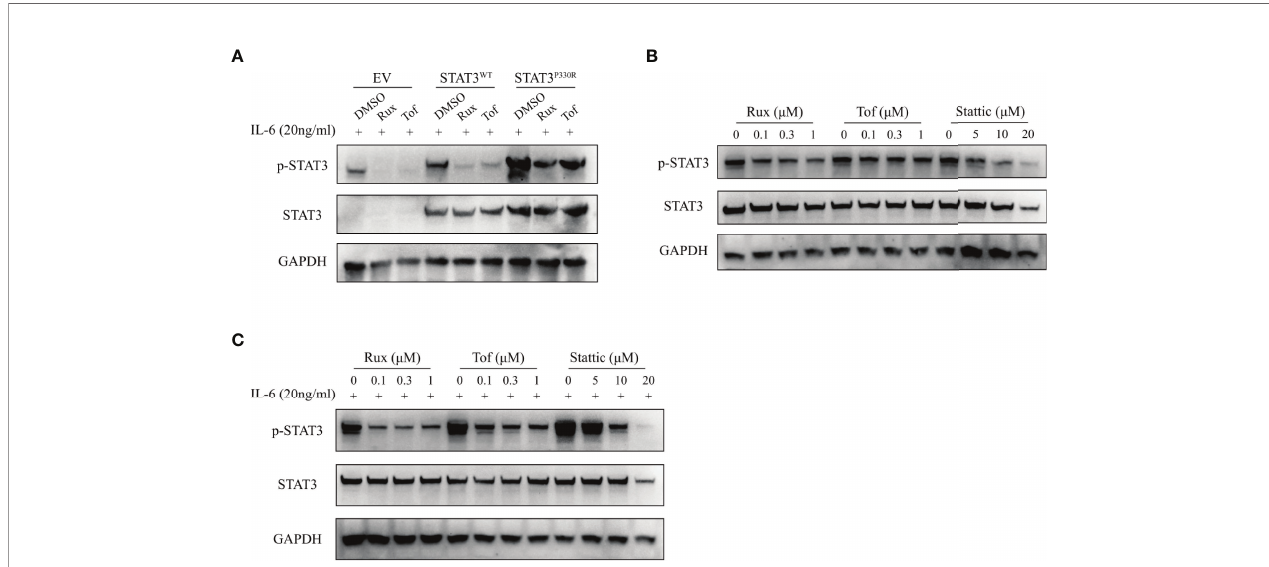
FIGURE 5 | The suppression of STAT3 phosphorylation by JAK and STAT3 inhibitors. (A) The transfected HEK293 cells were treated with dimethylsulphoxide (DMSO), ruxolitinib (Rux), or tofacitinib (Tof), respectively, and then activated with IL-6 (20ng/ml). The phospho-STAT3 level was examined. (B, C) The transfected HEK293 cells were treated with ruxolitinib, tofacitinib or stattic at the indicated concentration and then activated without (B) or with (C) IL-6 (20ng/ml). The phosphorylation of STAT3 was examined by western blot. The total STAT3 and GAPPDH were used as the loading